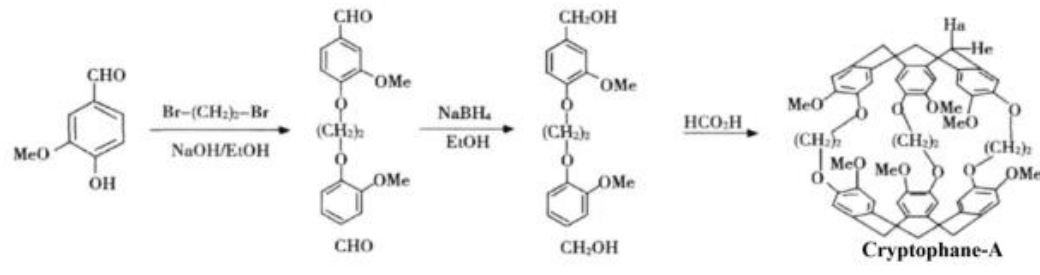
Figure 3. Cryptophane-A synthetic route.